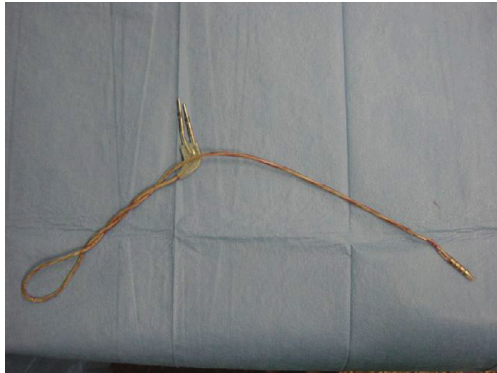
Figure 3: Appearance of the right extension lead during the third